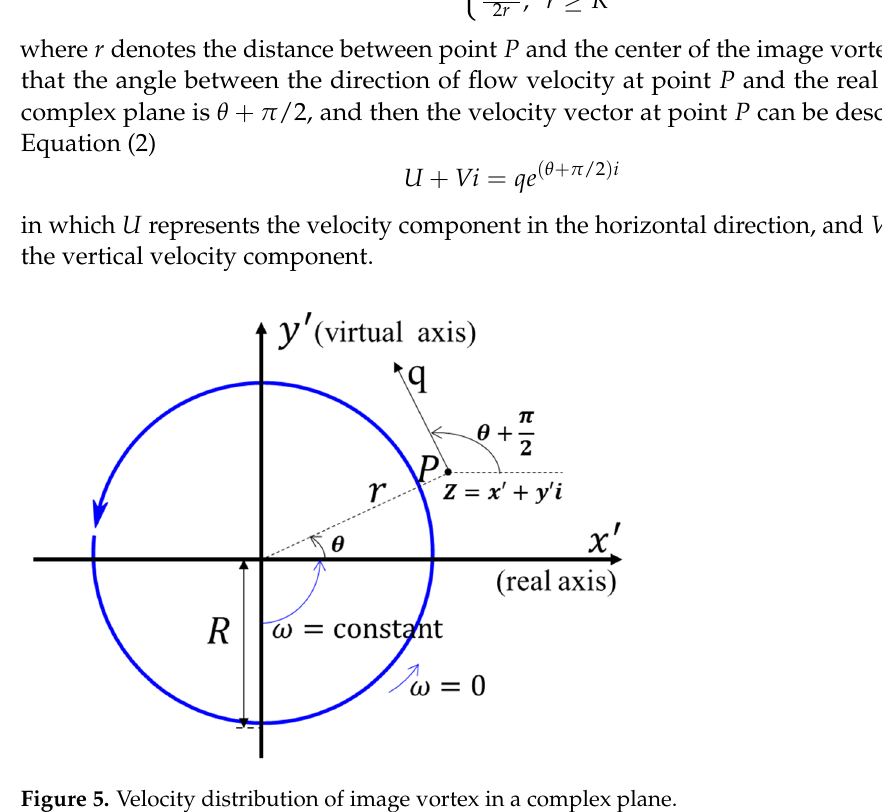
Figure 5. Velocity distribution of image vortex in a complex plane. When the flow field outside the image vortex is assumed to be potential flow, the velocity field around the vortex can be described with a simple and general method of the complex potential function represented by W = ϕ + ψ i , where ϕ = ϕ ( x (cid:48) , y (cid:48) ) denotes the potential function outside the image vortices, and ψ = ψ ( x (cid:48) , y (cid:48) ) represents the flow functions outside the image vortices. The coordinates of a point P outside the image vortex are written in the form Z = x (cid:48) + y (cid:48) i = re θ i , and then the derivative of W with respect to Z at point P can be represented by Equation (3).